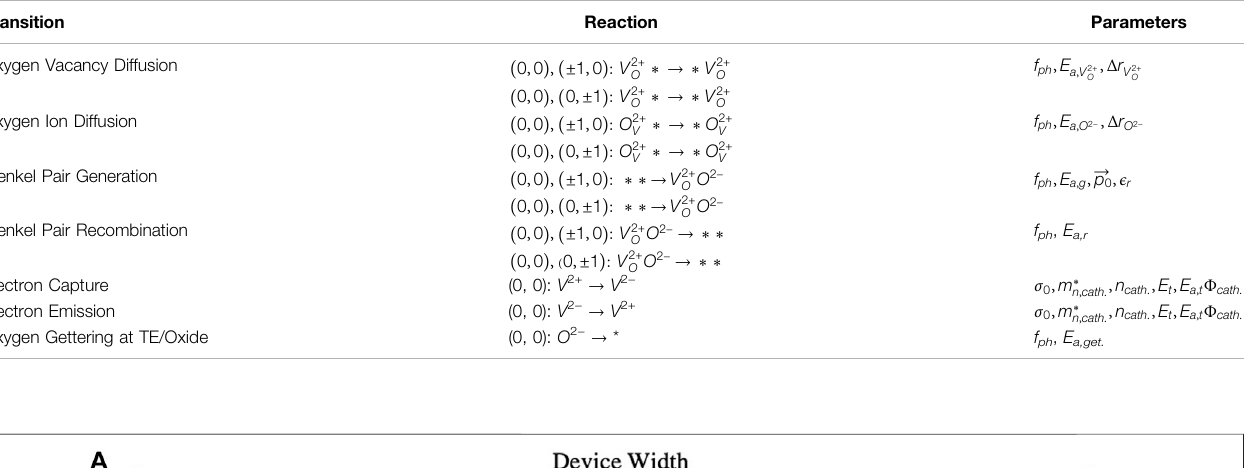
TABLE 2 | Summary of transitions rates modelled using Kinetic Monte Carlo procedure and their parameters. Lattice coordinates are listed as relative positions to a given lattice point at ( i , j ) following the convention of the lattice gas model (Jansen, 2012). * (cid:2) site, O 2 − (cid:2) oxygenion, V 2 + O (cid:2) positively charged oxygen vacancy ( unoccupied ) , V 2 − O (cid:2) negatively c harged oxygen vacancy ( occupied )